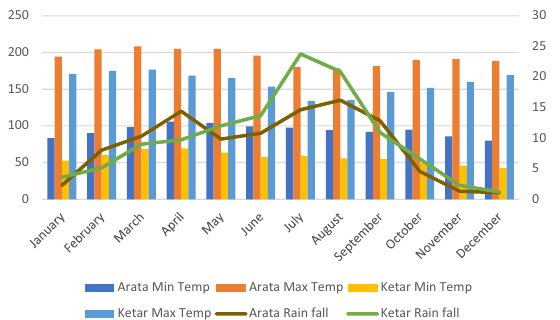
Fig. 4 Climate pattern of Arata and ketar catchment